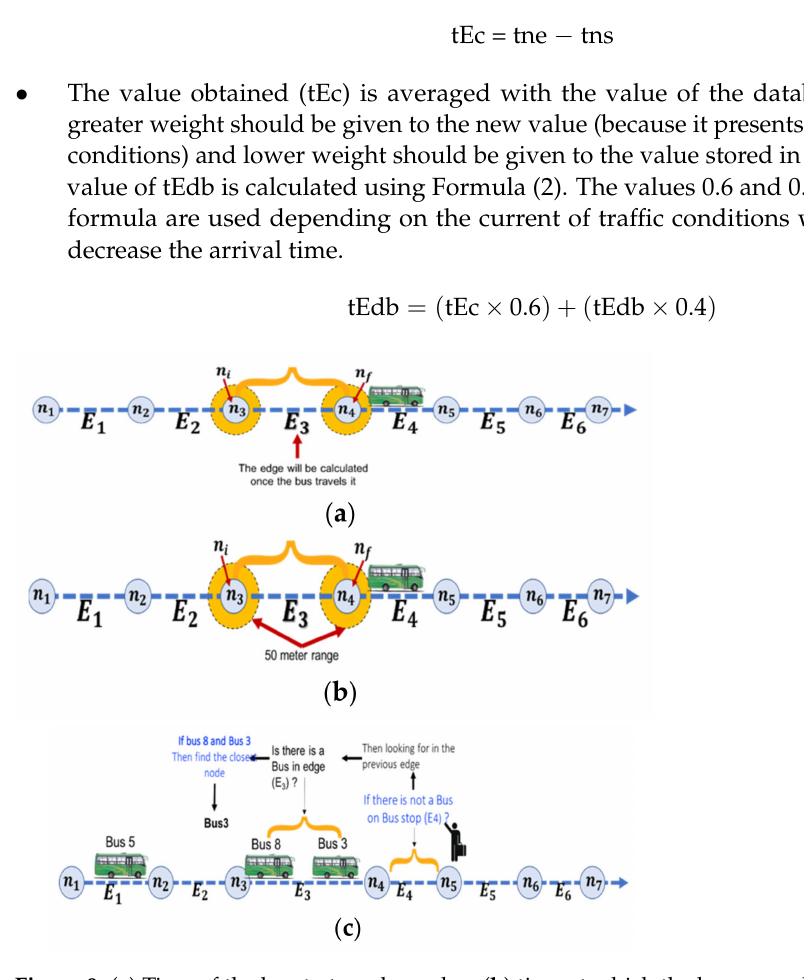
Figure 9. ( a ) Time of the bus to travel an edge; ( b ) time at which the bus passed the start node and the end node; ( c ) search for the closest